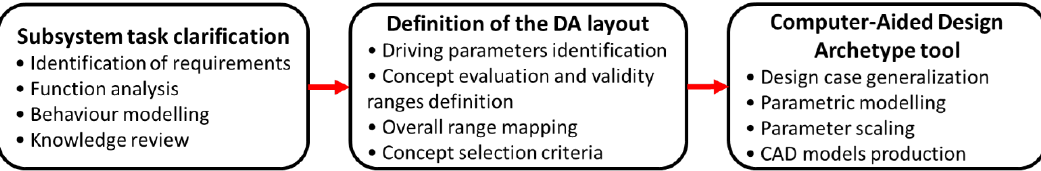
Figure 2. Method phases for the development of a design archetype.